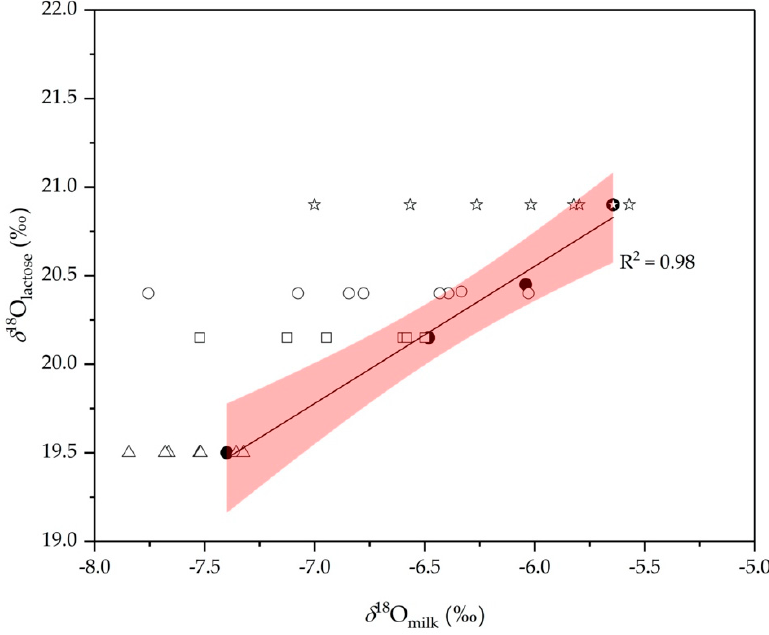
Figure 7. Relationship between δ 18 O milk and δ 18 O lactose values of authentic samples together with the regression line and 95% of confidence levels (R 2 = 0.98). The data for diluted milk from Ajdovš č ina, Č rna na Koroškem, Selnica pri Dravi in Ormož are also included. From right to left, points show the δ 18 O milk when adding 3%, 5%, 7%, 10%, 20% and 30% of water to milk.